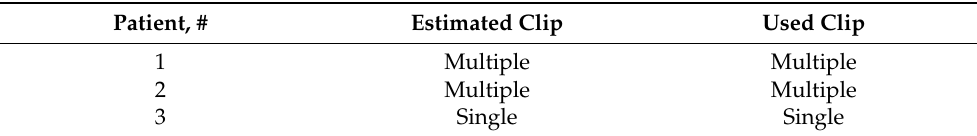
Table 7. Comparison between the planned and the used approach for the treatment of the three patients’ aneurysms. The multiple clipping strategy is proposed for tightly adhered vessels to the aneurysm, while the single clipping strategy is for vessels that are fully detachable. For the characteristics of the patients, please refer to Table